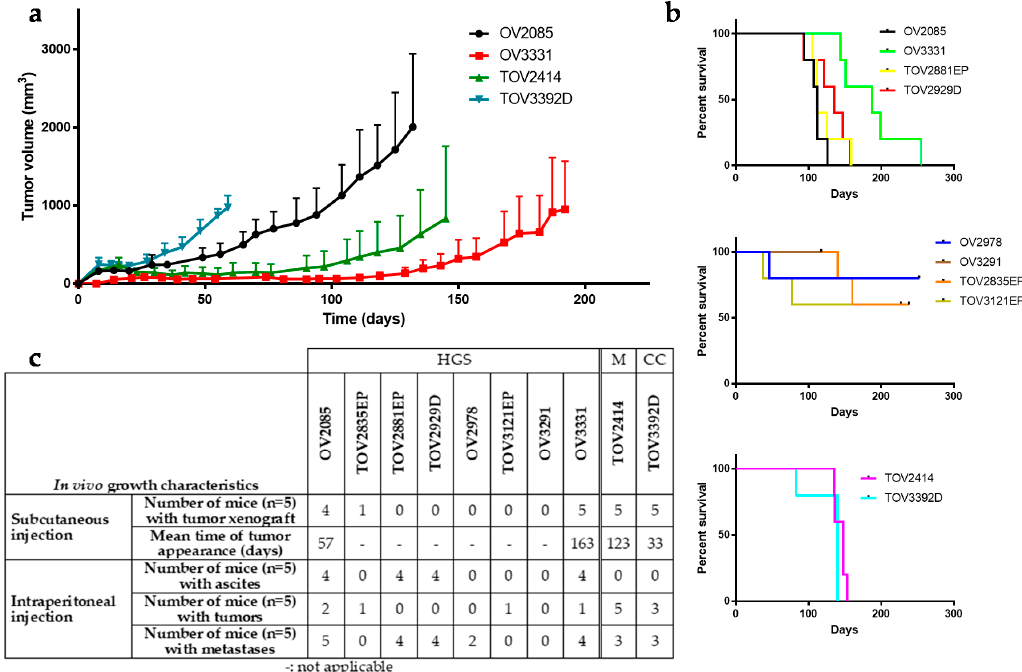
Figure 7. In vivo growth characteristics. ( a ) Evolution of tumor volume after SC injection in NRG mice, for cell lines that induced observable tumor growth ( n = 5). Points represent average ± SEM, and curves were plotted when end points were attained per group, when the first animal was sacrificed. ( b ) Kaplan–Meyer survival curves of NRG mice after IP injection with each of the cell lines ( n = 5). For clarity, cell lines were separated and grouped by HGSC that formed ( top ) or did not form ( middle ) tumors, ascites, and/or metastases in at least 3/5 mice, and non-HGSC cell lines ( bottom ). Censored data points represent mice that had reached end points. ( c ) Summarizing table of in vivo growth characteristics.